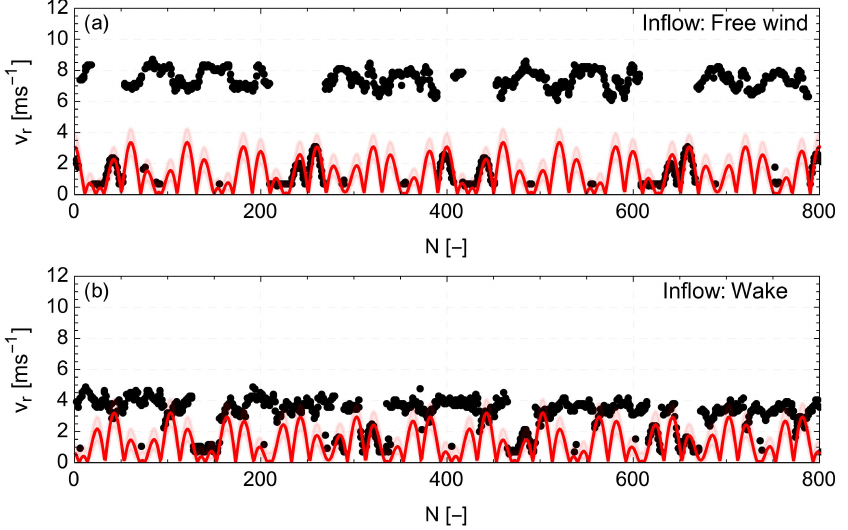
Figure 10. Time series of radial speed measurements (black points) acquired with a 200 Hz sampling frequency. The theoretical speed, if it is assumed that the lidar is detecting all the time a rotating blade, is presented with a red line. The estimated deviation from this value due to the varying speed of the rotor within a 10 min period is marked by the red-opaque shaded area. The time series correspond to different inflow cases: (( a ) free flow and ( b ) wake